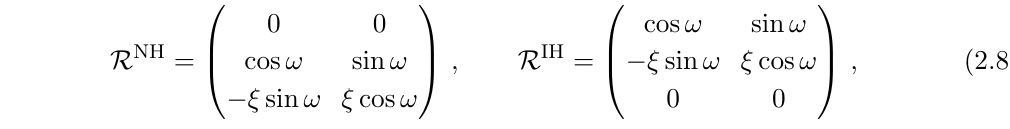
table 1. Further, (cid:14) is the so-called Dirac phase, while (cid:11) are referred to as the Majorana 1 ; 2 phases. In the case of two generations of sterile neutrinos only one combination of the Majarona phases is physical, i.e. for normal hierarchy (NH) it is (cid:11) , while for inverted 2 hierarchy (IH) it is (cid:11) (cid:0) (cid:11) . Without loss of generality we can set (cid:11) (cid:17) (cid:11) and (cid:11) = 0. 2 1 2 1 The mixing of the doublet state (cid:23) with the singlet state (cid:23) implies a deviation of V from (cid:23) L R unitary. The complex matrix R in eq. (2.2) ful(cid:12)ls the orthogonality condition R T R =